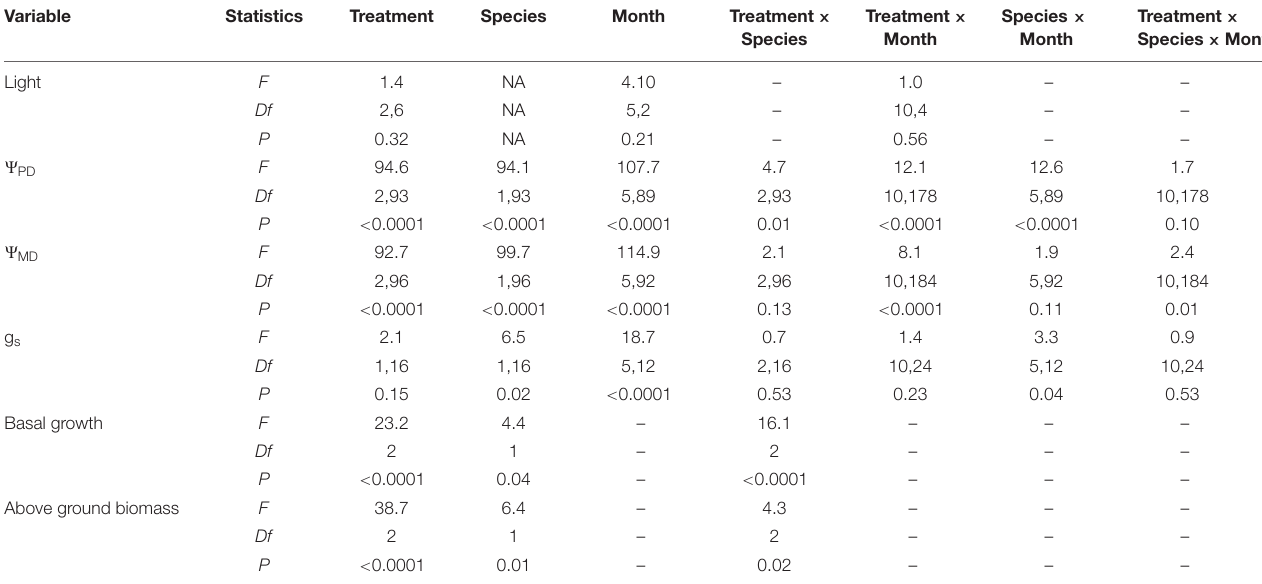
TABLE 1 | ANOVA Statistics for light, predawn water potential ( (cid:57) PD ), midday water potential ( (cid:57) MD ), stomatal conductance (g s ), basal diameter growth, and aboveground biomasss accumulation in Douglas-fir and redwood seedlings after partial harvesting treatments in Maple Creek, CA.